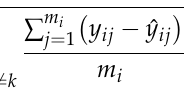
Figure 2. Workflow for model training, hyperparameter optimization and model selection.